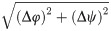
Comparison of the OF [14] and IF [15] crystal structures of Mhp1.
(A) A superimposition of the two crystal structures, with the extracellular side up. The EL4 extracellular loop (between the OUT7-8 helix and TM8) and the IL2 intracellular loop (between TM4 and TM5) are highlighted. (B) The backbone structures for the EL4 and IL2 loops in the OF and IF conformations. The side chain of Ile161 in the IL2 loop is also shown. Two distances, between S295:H and V291:O in the EL4 loop and between I164:H and G160:O in the IL2 loop, are labeled. (C) Difference in the backbone torsions. For each residue, the differences in the backbone φ and ѱ angles between the OF and IF crystal structures are calculated, and the combined deviation (Δφ)2+(Δψ)2 is plotted.